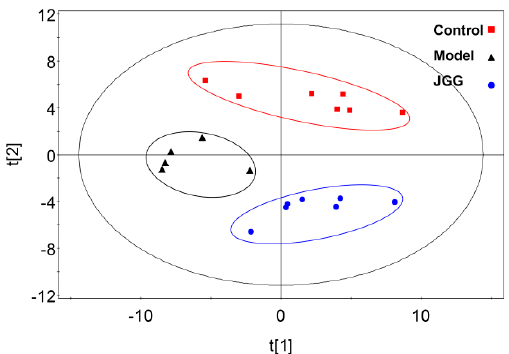
Figure 4. Score plots from the PCA model derived from the UPLC-MS profile of serum obtained from rats. : control; : model; : JGG . The ellipses are only for easier data visualization.